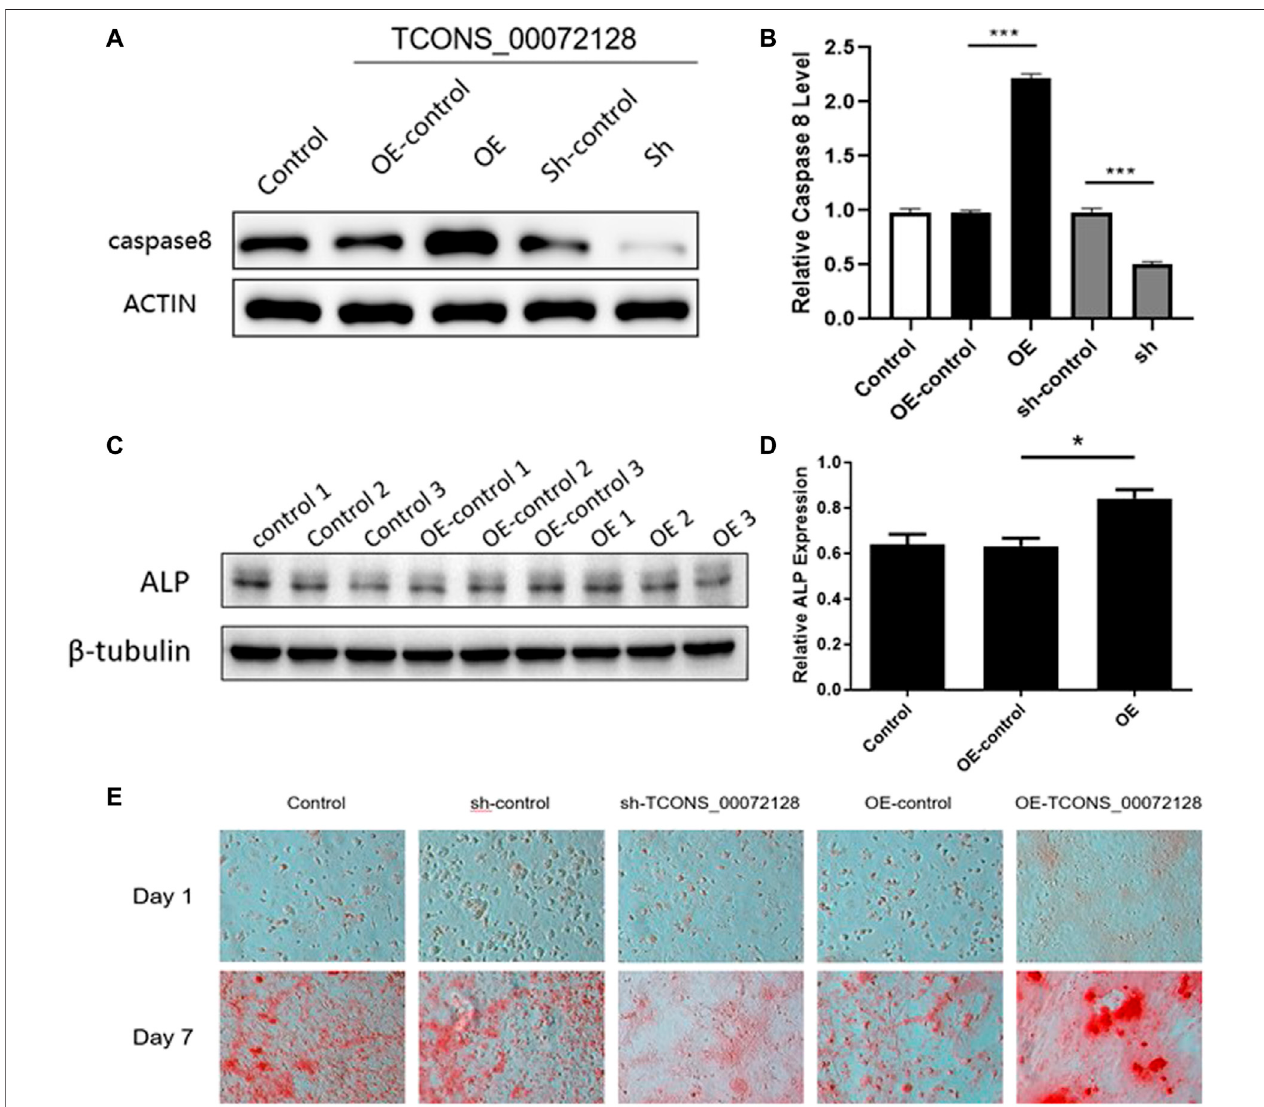
FIGURE 4 | Role of TCONS_00072128-mediated caspase-8 activation in osteogenic differentiation of BMSCs. (A – D) Western blot analysis with caspase 8and ALP extracted from BMSCs treated with lentivirus infection. OE, overexpressed TCONS_00072128. Sh, depressed TCONS_00072128. (E) ARS staining for BMSCs treated with lentivirus infection at day 1 and day 7. All results are presented with three replicates. * p ≤ 0.05, *** p ≤ 0.001.